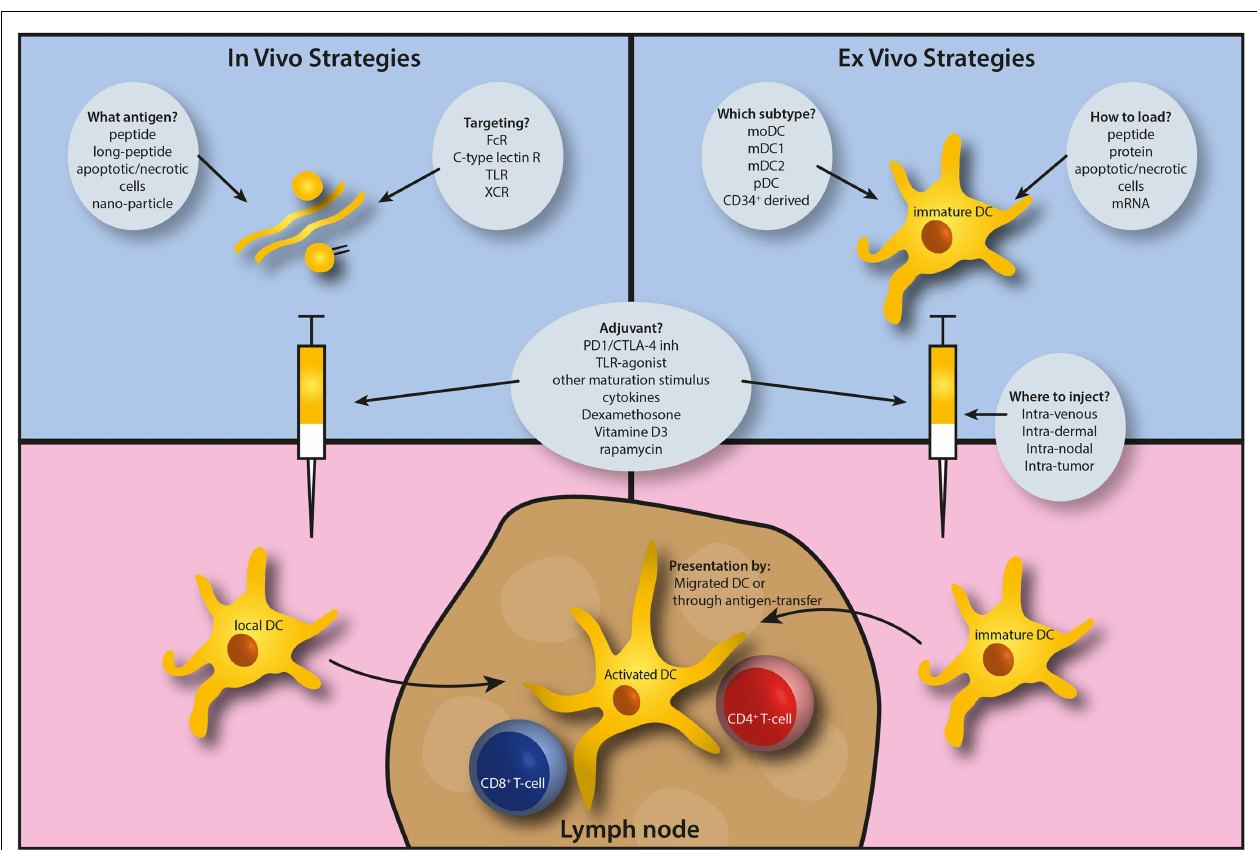
FIGURE 1 | Schematic outline of the considerations to apply antigen cross-presentation research to the clinic, most readily by dendritic cell-based